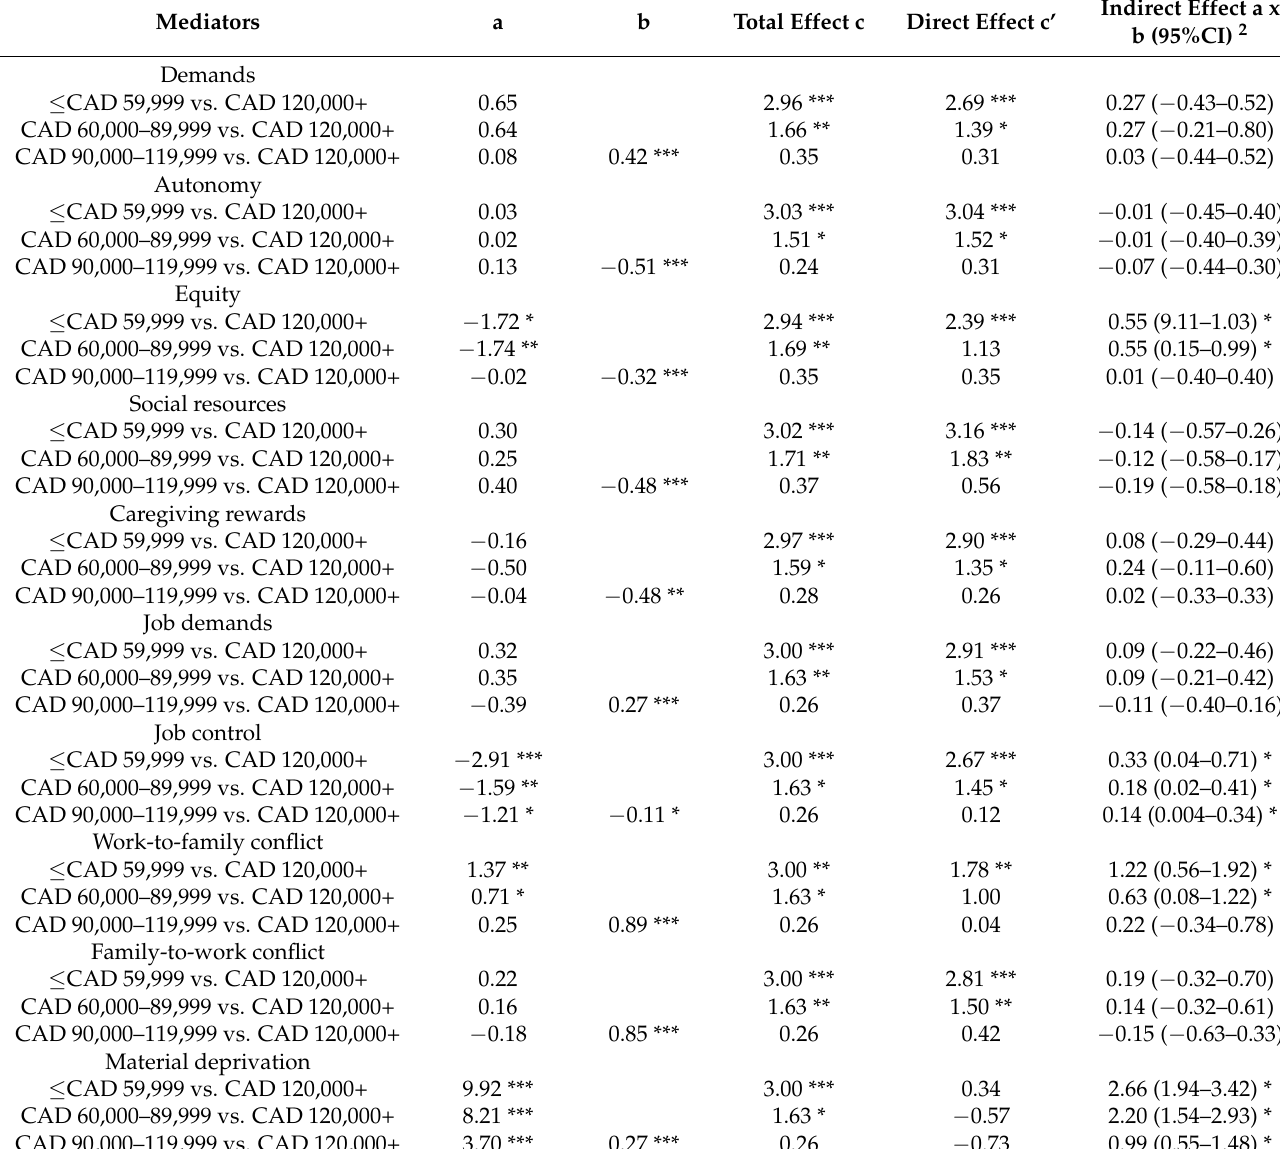
Table A2. Simple mediation analyses of the effect of household income on psychological distress, mediated by variables measuring family work quality, job quality, the work–family interface, and material deprivation 1